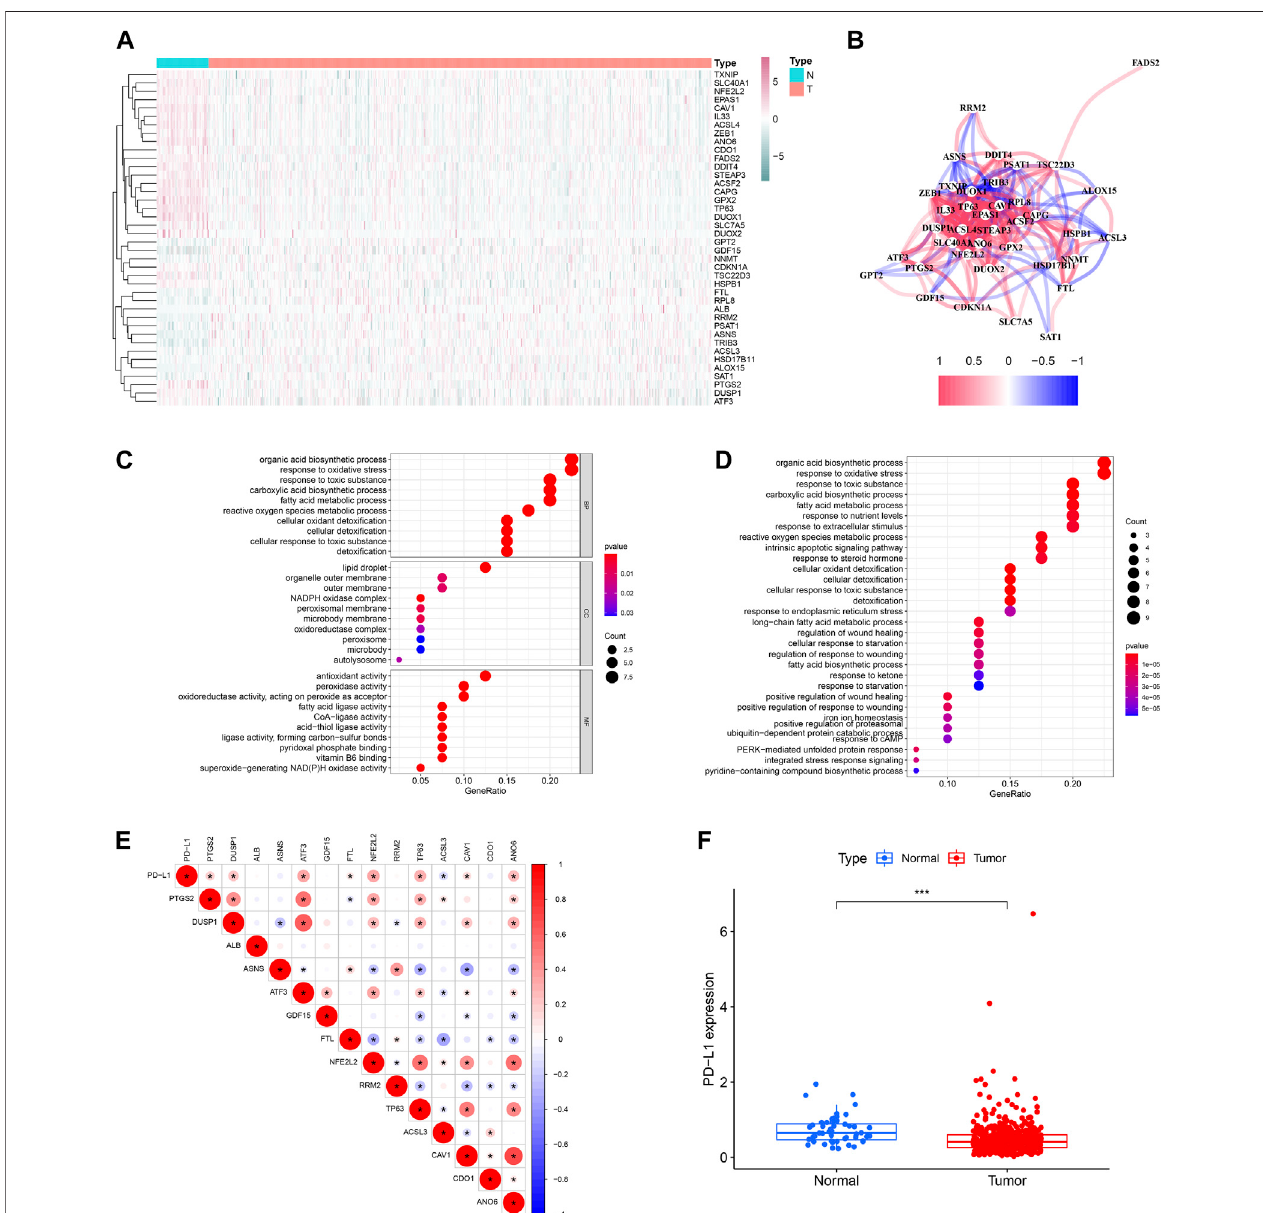
FIGURE 2 | The heatmap (A) , correlation network (B) and GO (C) and KEGG enrichment (D) of 40 ferroptosis-related differentially expressed genes. The expression correlation ofPD-L1 with 14ferroptosis-related prognostic differentially expressed genes (E) .The expression level ofPD-L1 betweenPCa tissue and normal tissue (F)